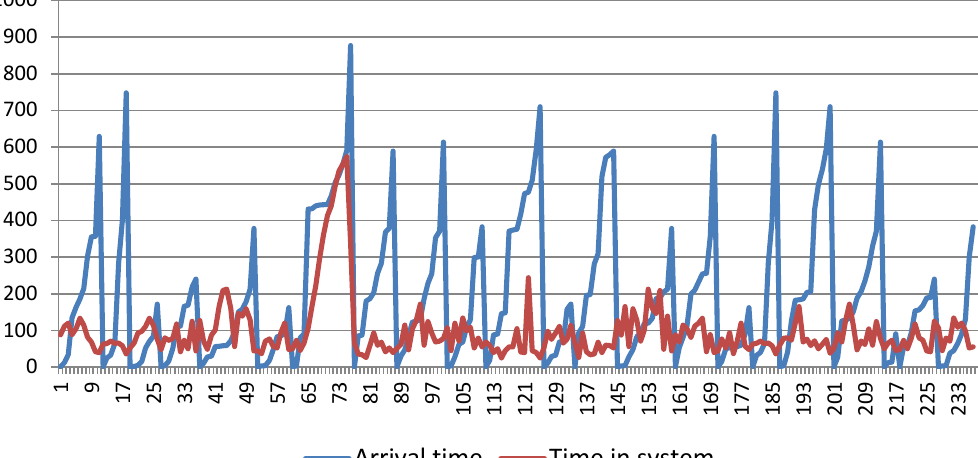
Figure 4. Time in the system and cumulative arrival time for 237 trucks.